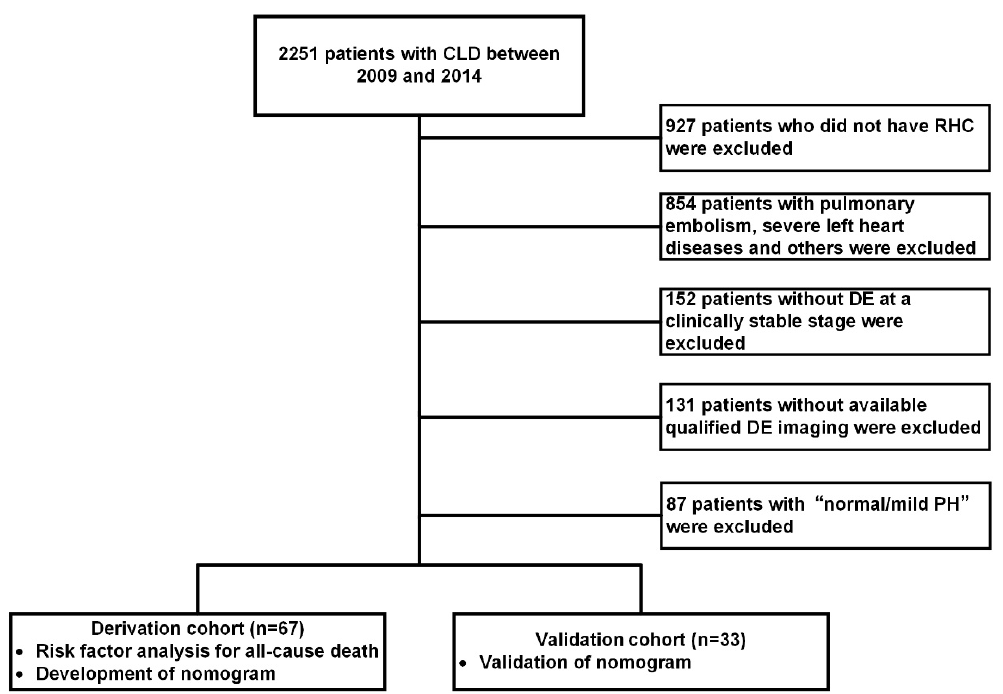
Figure 1. Flow diagram of patient enrolment and study design. CLD: chronic lung diseases; DE: Doppler echocardiography; RHC: right heart catheterization. Table 1. Demographics and Baseline Characteristics of Severe PH in the Derivation and Validation Cohorts.